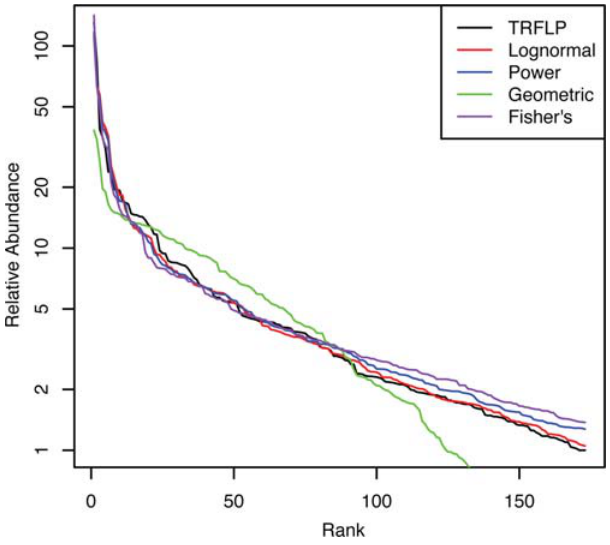
Figure 6. TRFLP data for soil and the distributions that provided the best fit to this data. Goodness-of-fit measurements are given in Table 3.